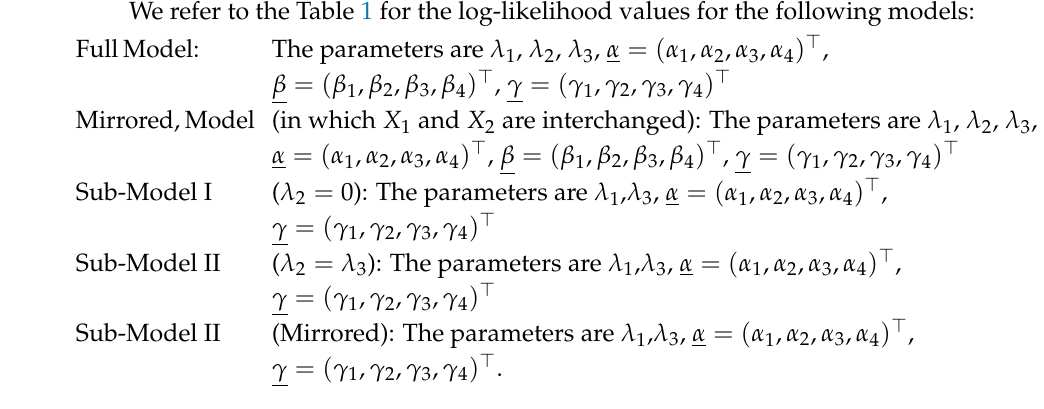
Table 1. Models for the Australian Health Service Utilization Data.